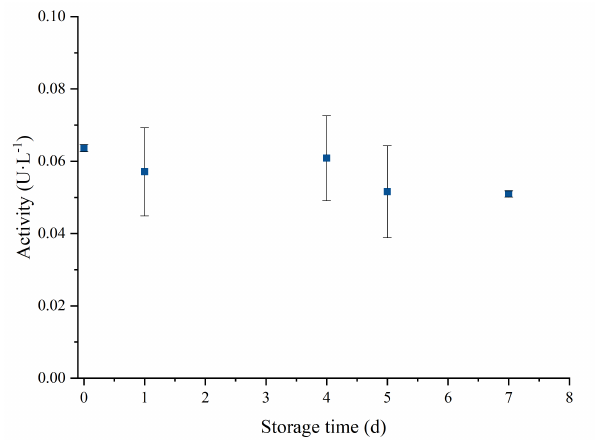
Figure 5. Effect of storage on the conversion of ABTS with enzymatic membrane. Enzymatic membranes were prepared by using the optimal conditions for adsorption (conditions: laccase concentration: 3 mg·mL − 1 , adsorption time: 9 h, temperature of adsorption: 29 ◦ C, time of cross- linking: 2 h, temperature of cross-linking: 4 ◦ C, GA: 100 mM, temperature of storage: 4 ◦ C).